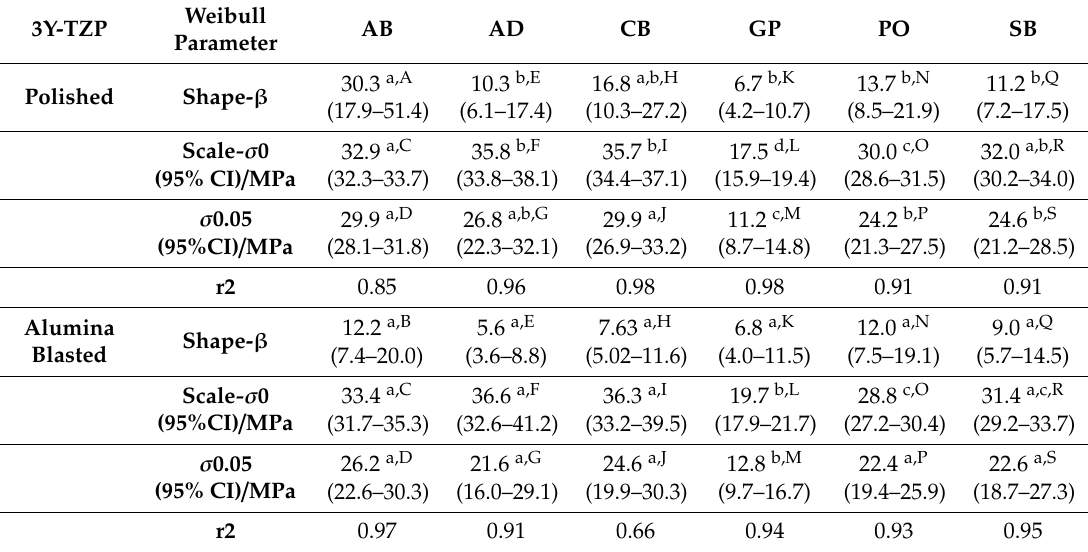
Table 4. The results of the Weibull analysis of the shear bond strength of 3Y-ZTP specimens. Same lowercase superscript letters show values with no statistically significant di ff erence within each row, and same uppercase superscript letters show values with no statistically significant di ff erence for the same parameter within each column ( p >